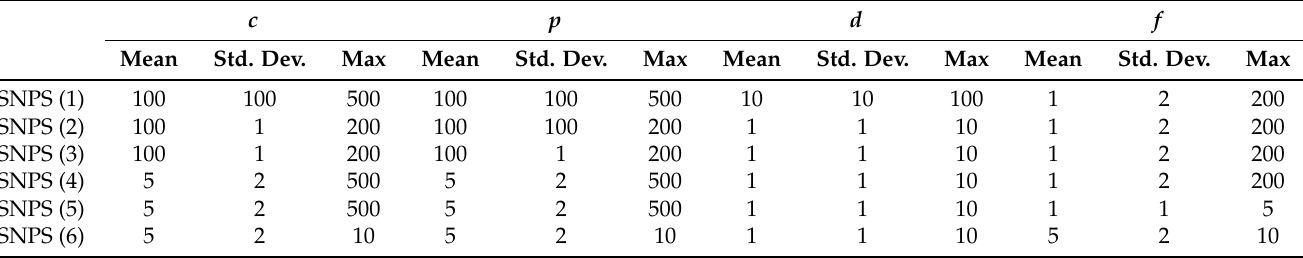
Table 6. Mean, std. dev., and max. value for each evolved parameter in the tested NEAT